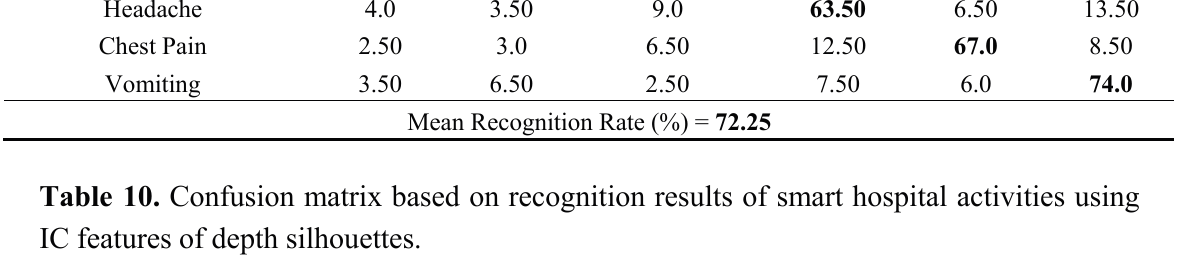
Taking Medicine